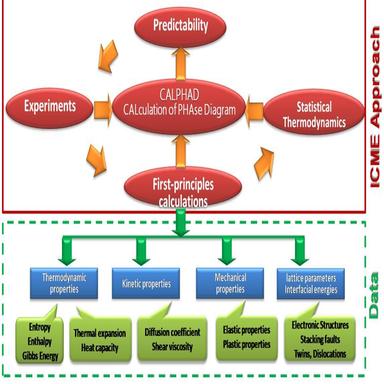
The schematic diagram presenting the road-map of data-driven integrated computational materials engineering (ICME) approach, which combining the firstprinciples calculations and the calculated phase diagram (CALPHAD) modeling in the development of advanced Mg alloys.